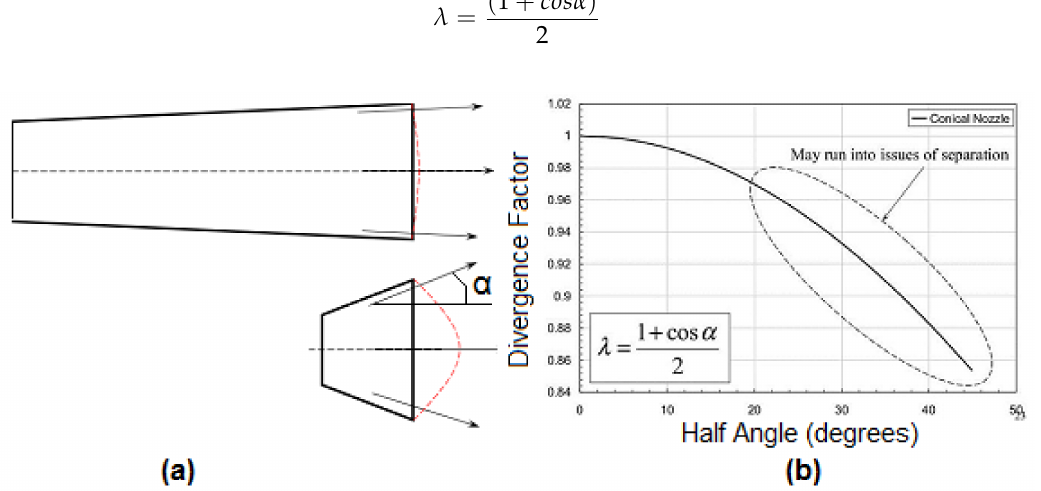
Figure 6. ( a ) ( Top ) Mostly axial thrust, ( Bottom ) mostly radial thrust; ( b ) and the divergence factor in relation to the nozzle geometry